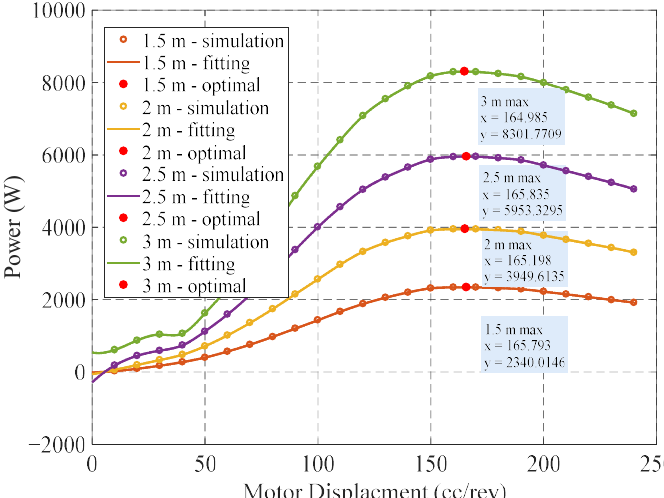
Figure 15. The generated power under different motor displacements and wave periods when keeping the generator load constant.